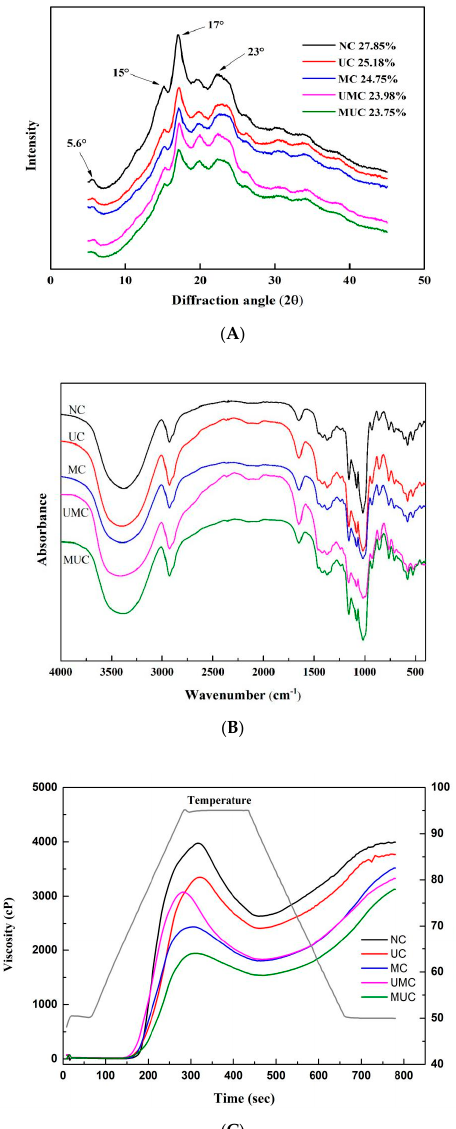
Figure 2. X-ray di ff raction diagrams ( A ), FTIR spectra ( B ) and Rapid Viscosity Analyzer (RVA) pasting profiles ( C ) of native and modified chestnut starches. The values mean relative crystallinity ( A